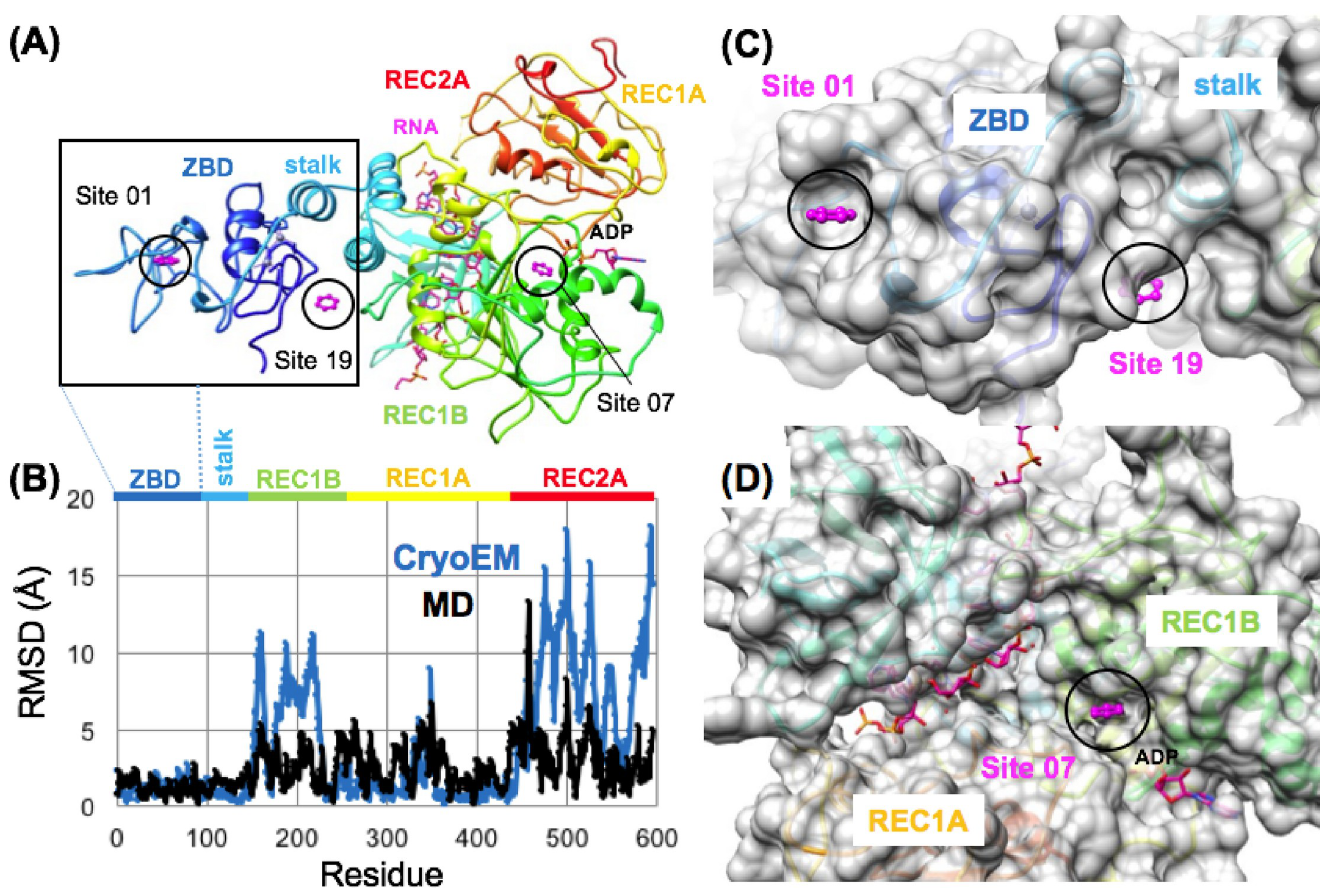
Fig 10. Domain structure and favorable aromatic pharmacophore sites on the Nsp13 helicase. Nsp13 structure is shown in a rainbow ribbon diagram in (A) where the N-terminal zinc-binding-domain (ZBD) is colored blue and the C-terminal REC2A domain is colored red. Favorable binding sites Site 01, Site 19 and Site 07 are highlighted in magenta and labeled. The location of RNA and ADP binding are modeled onto the structure via a structural alignment of another eukaryotic helicase (2xzl.pdb) bound to RNA and ADP. In (B) the root-mean-squared-deviation (RMSD) calculated between two recent Nsp13 helicase structures captured in different conformational states in a CryoEM structure of a complete SARS-CoV-2 replicase complex is shown in (blue). A similar RMSD as a function of residue plot is shown for 500 ps of standard molecular dynamics (MD) simulation of the (6jyt.pdb) structure at 310 K in all-atom solvent (black). Favorable binding sites Site 01, Site 19 and Site 07 are highlighted in magenta and shown bound to the Nsp13 helicase surface in (C) and (D) where Site 01 is the most favorable site on the entire Nsp13 helicase found on the N-terminal ZBD (C), where Site 07 was the most favorable site identified in the vicinity of the ATPase active site